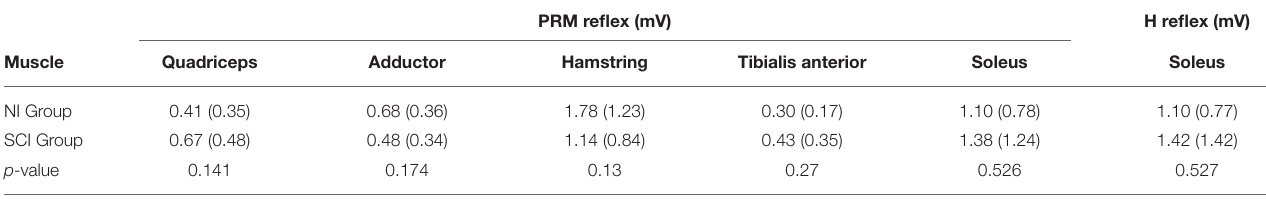
TABLE 2 | Mean (SD) standing reflex amplitudes.